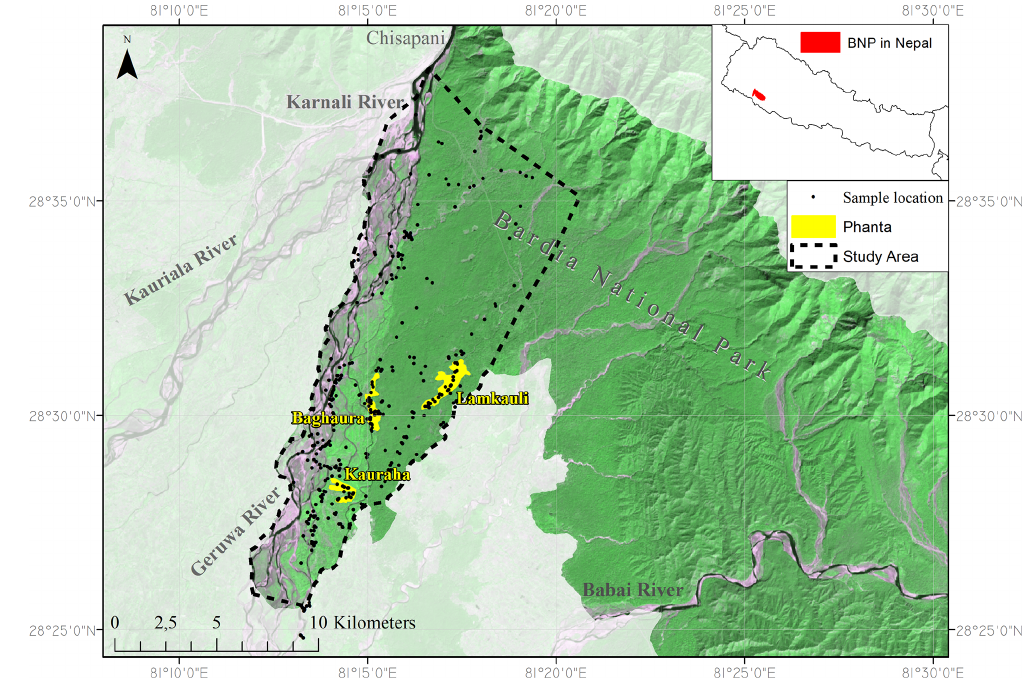
Figure 1. Delineation of Bardia National Park (dark green) and the study area (red) in and near the floodplain of the Karnali River. The megafan of the Karnali River lies between the two branches (the Kauriala and the Geruwa River) at the west side of Bardia National Park. This is a false colour composite (RGB = 656 of LANDSAT 8 imagery,